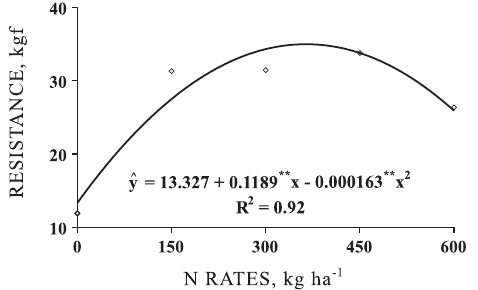
Figure 4. Resistance of Bermuda grass mat, in relation to N rates.